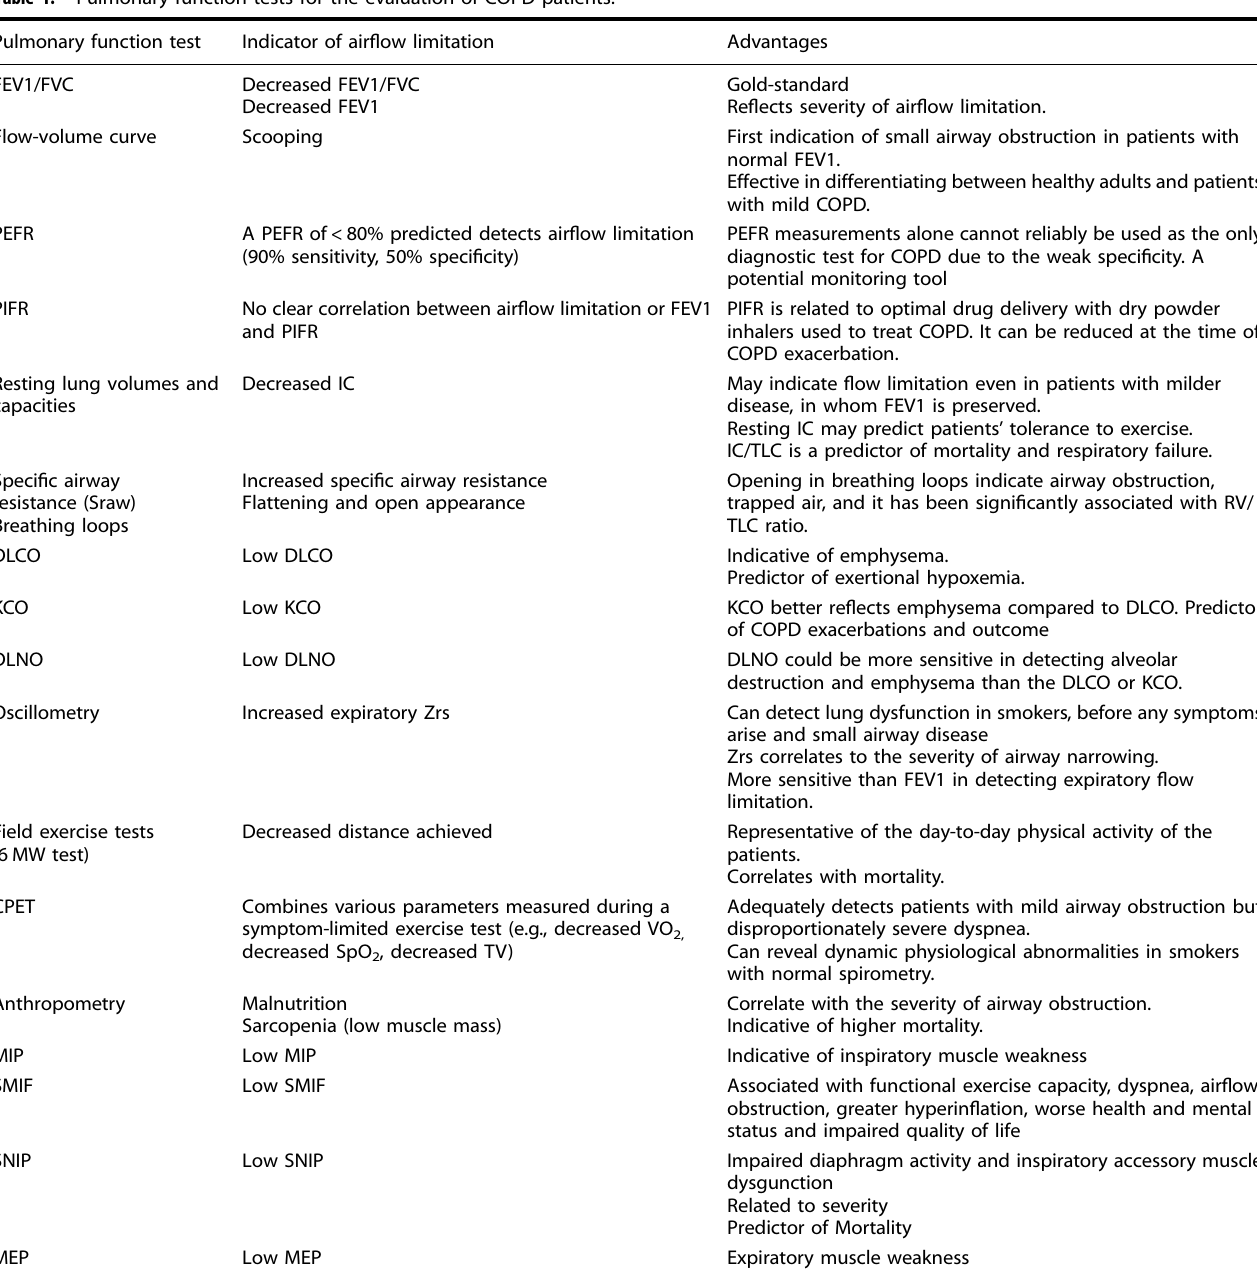
Table 1. Pulmonary function tests for the evaluation of COPD patients.